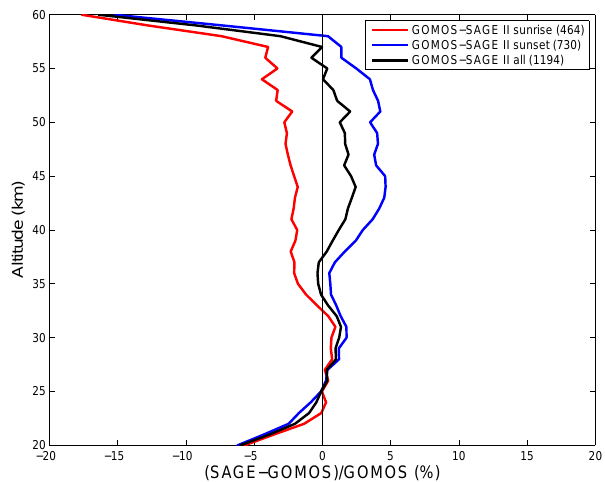
Fig. 3. The percent difference between SAGE II and GOMOS mea- surements for the collocations in 2002–2005. The corresponding differences between SAGE II sunrise and sunset measurements are also shown. The line labels show the number of